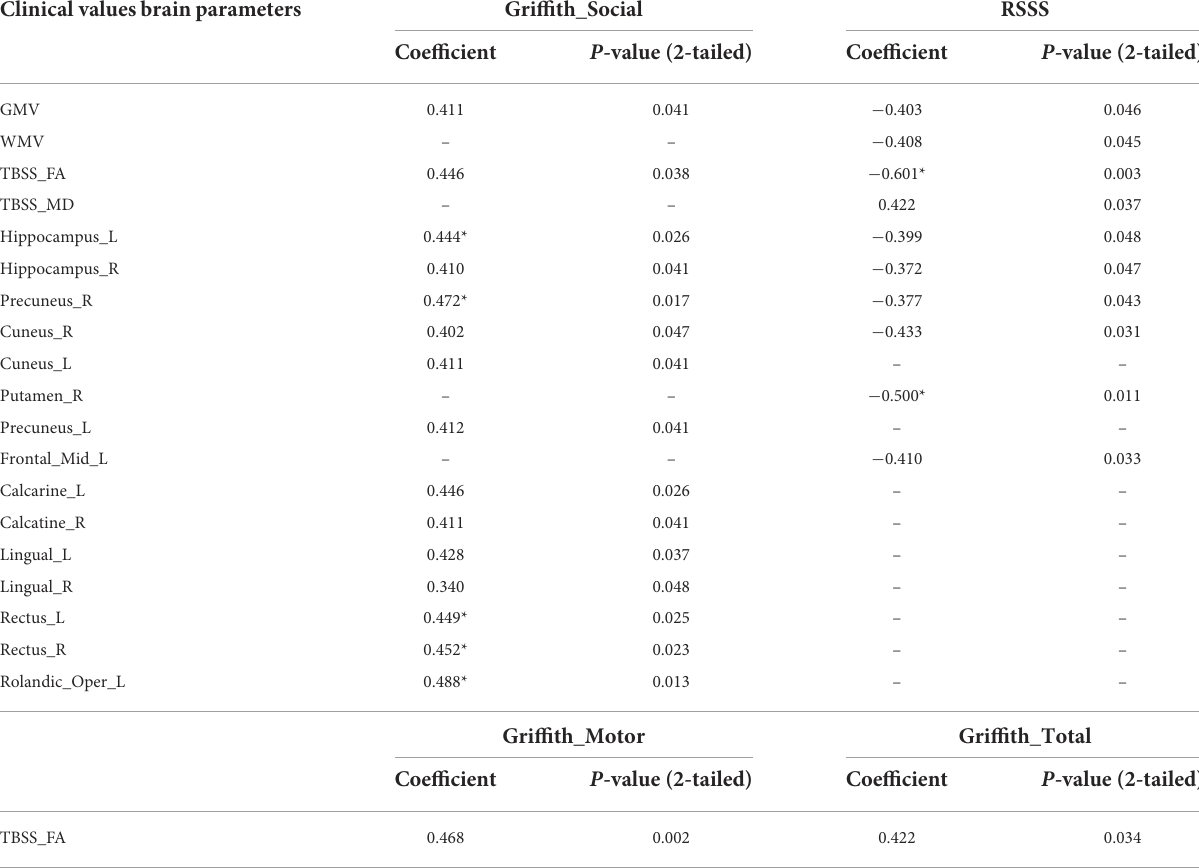
TABLE 4 Correlations between clinical data and altered gray and white matter parameters in the RTT group. Clinical values brain